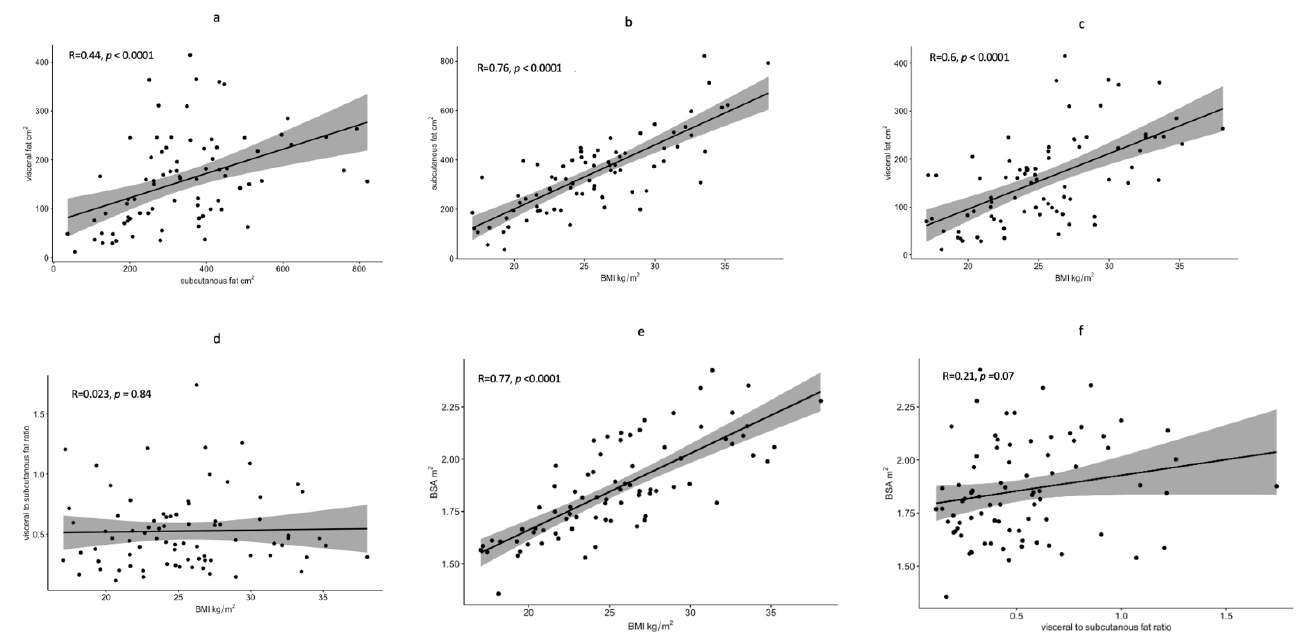
Figure 1. Scatter plot diagrams showing the Correlation between SAT and VAT ( a ); between BMI and SAT ( b ); between BMI and VAT ( c ); between BMI and VSR ( d ); between BSA and BMI ( e ); and BSA and VSR ( f ), black dots represent measurements from 81 patients, the solid line represents the regression line and grey shadow represents the confidence interval.